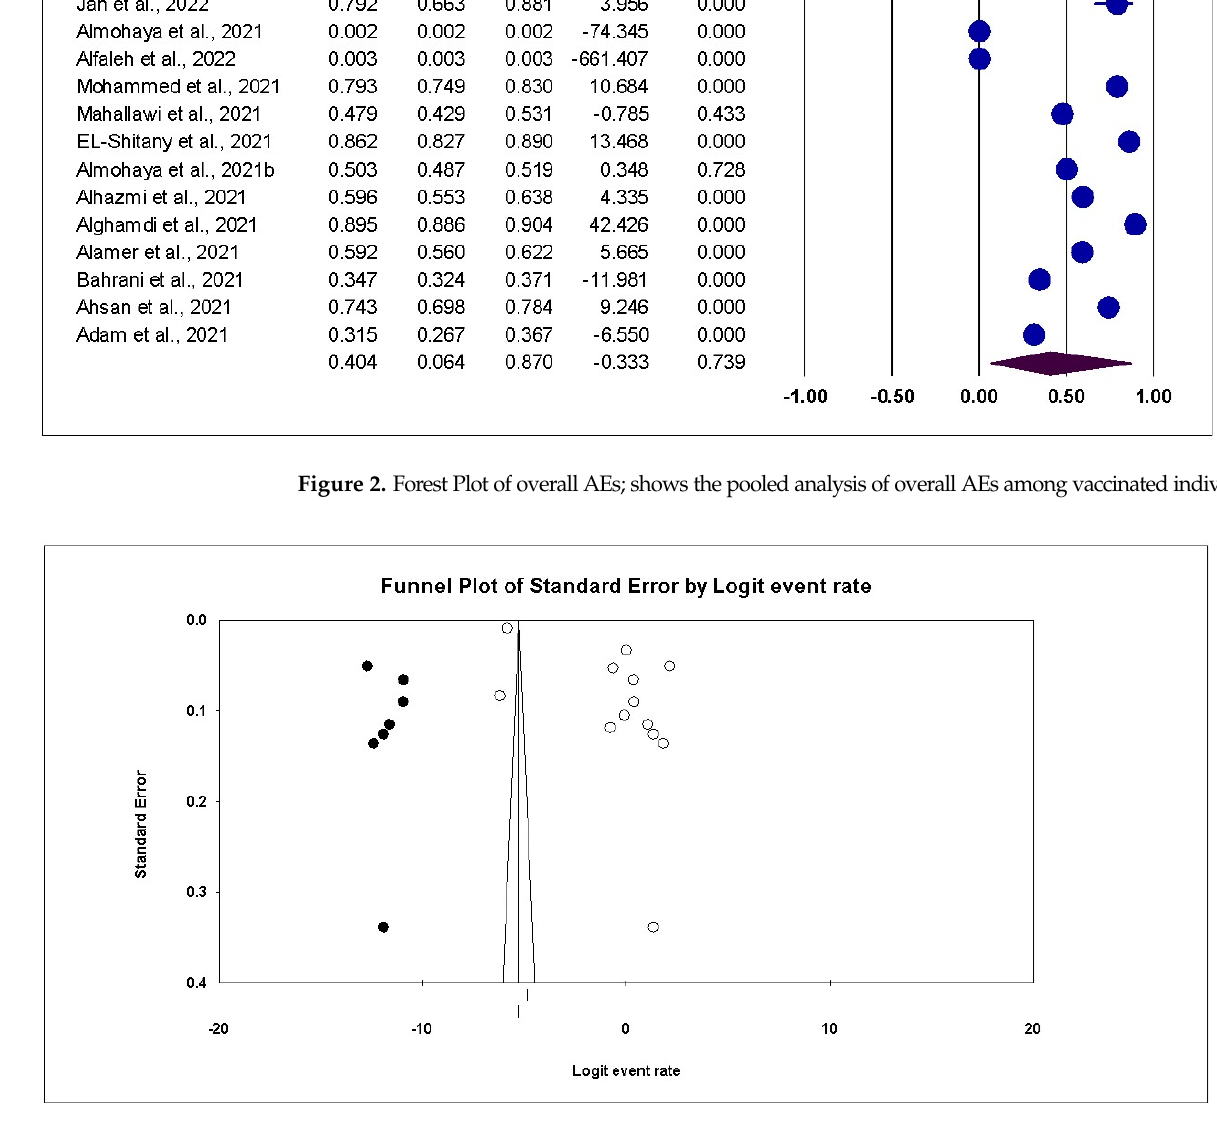
Figure 3. Funnel plot of standard error by the logit event rate.